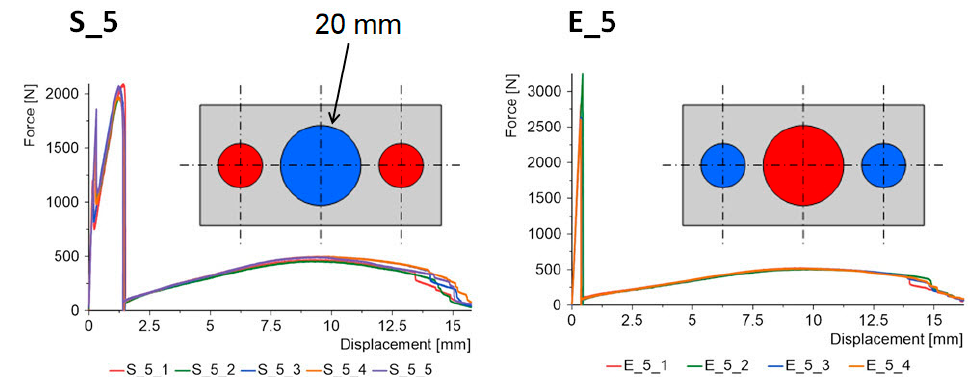
Figure 10. Triple-adhesive samples, batch 4.